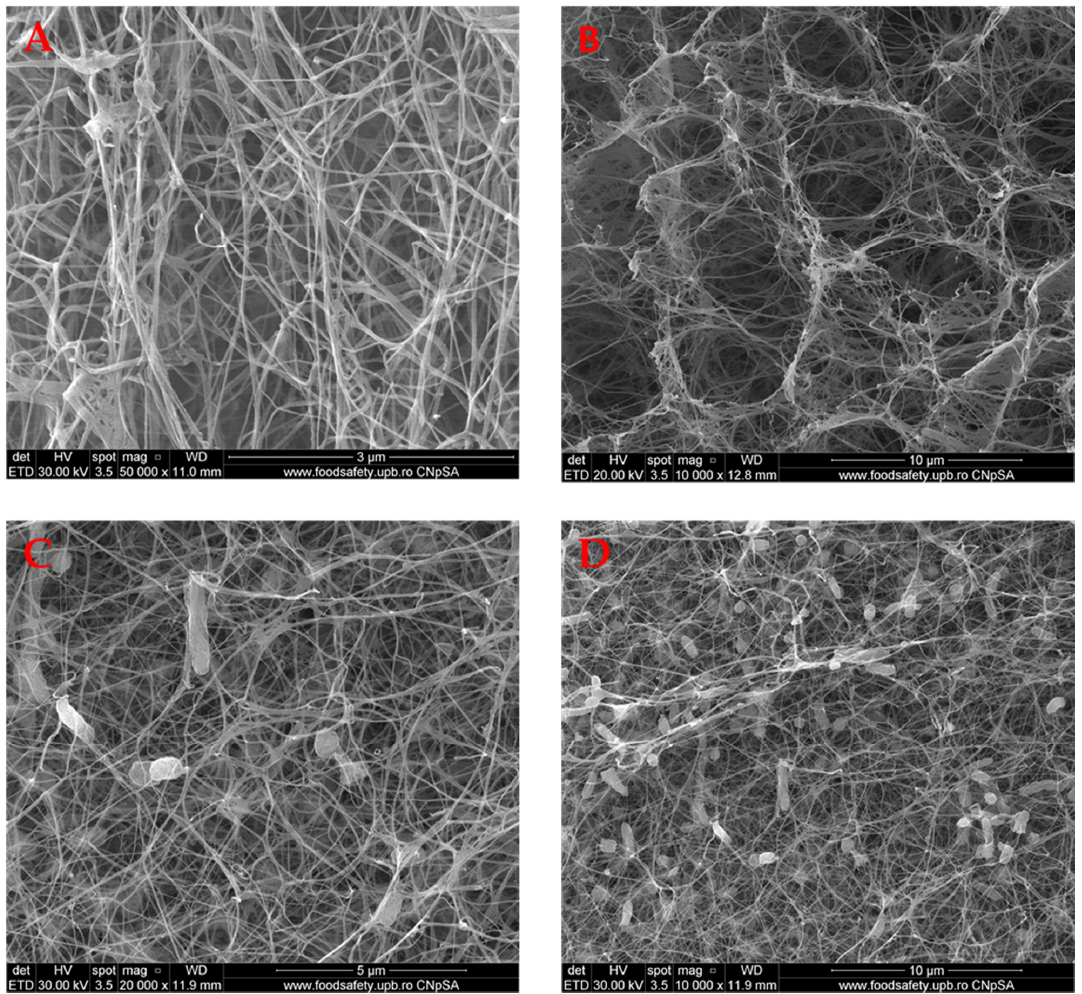
Figure 1. BC control SEM images, showing the fiber morphology on the surface ( A 50,000 × ; B 10,000 × ) and in cross-section ( C 20,000 × ; D 10,000 ×